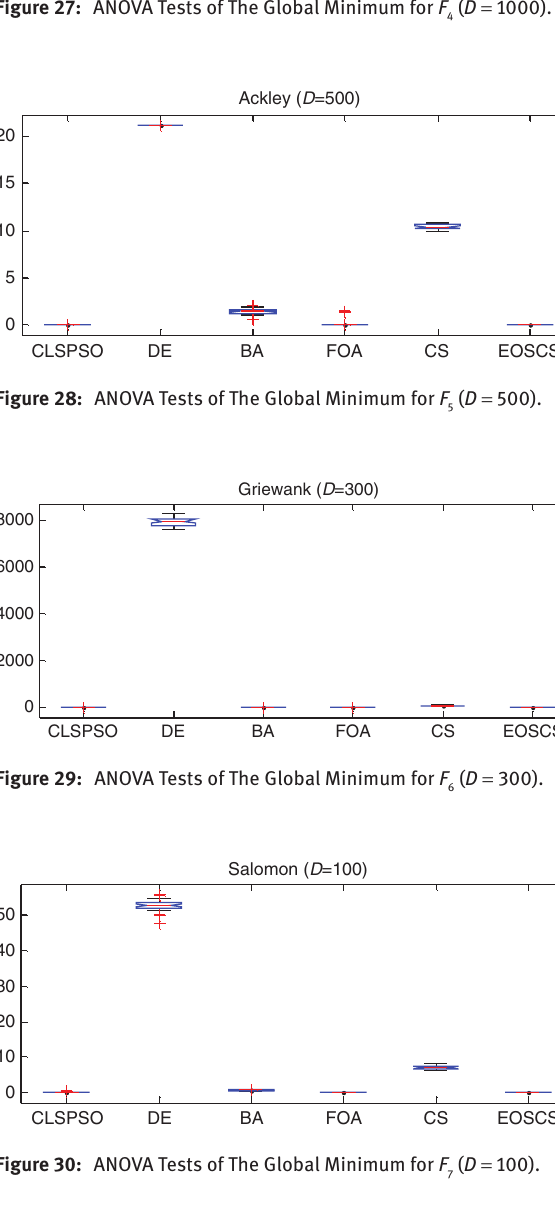
Figure 27: ANOVA Tests of The Global Minimum for F